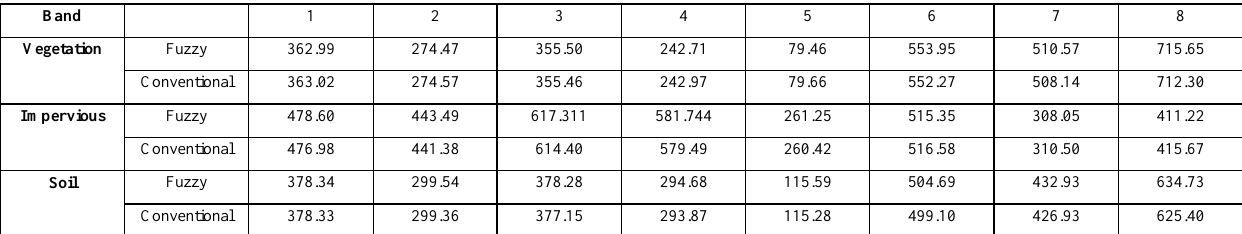
Table 2. Fuzzy and conventional mean values for the V-I-S classes.